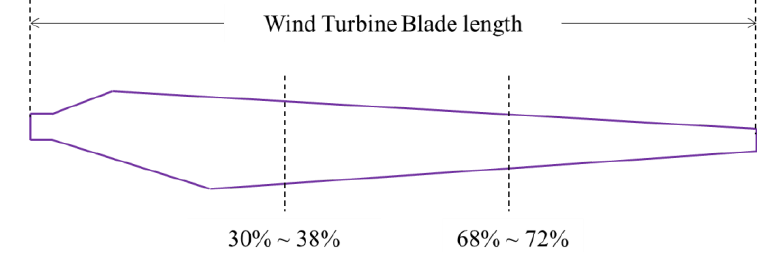
Figure 4. The spanwise location of a wind turbine blade that is likely to damage